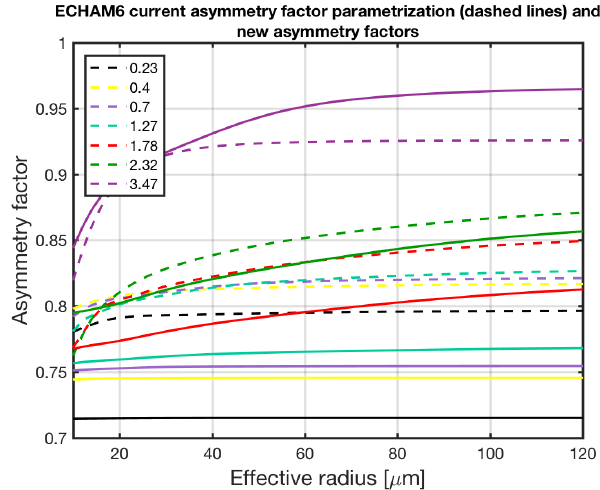
Figure 7. Comparison of the standard parameterization in ECHAM- HAM of the asymmetry factor of ice particle with different effective radius (dashed lines) and the new parameterization using severely roughened column aggregates (solid lines) for different wavelength bands. The wavelength bands are named after the band effective wavelength.